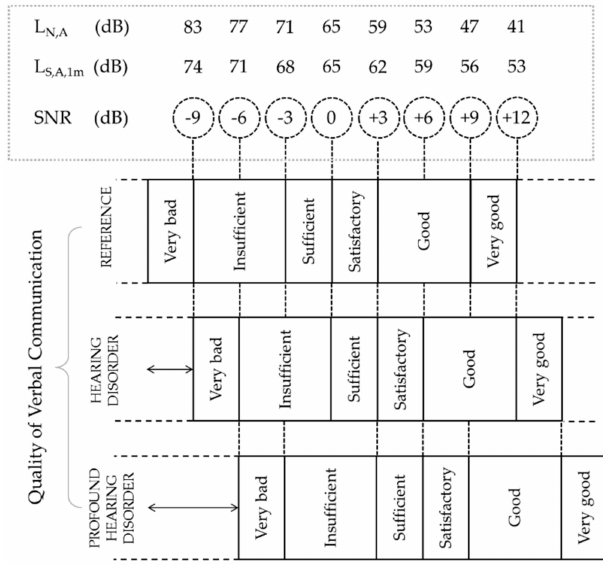
Figure 4. Threshold values of speech levels and ambient noise levels for the quality of verbal communication and its relation to SNR as suggested: by Lazarus [38] for reference listeners; inferred from ISO 9921 for listeners with slight hearing disorders [39]; hypothesised for listeners with profound hearing disorders